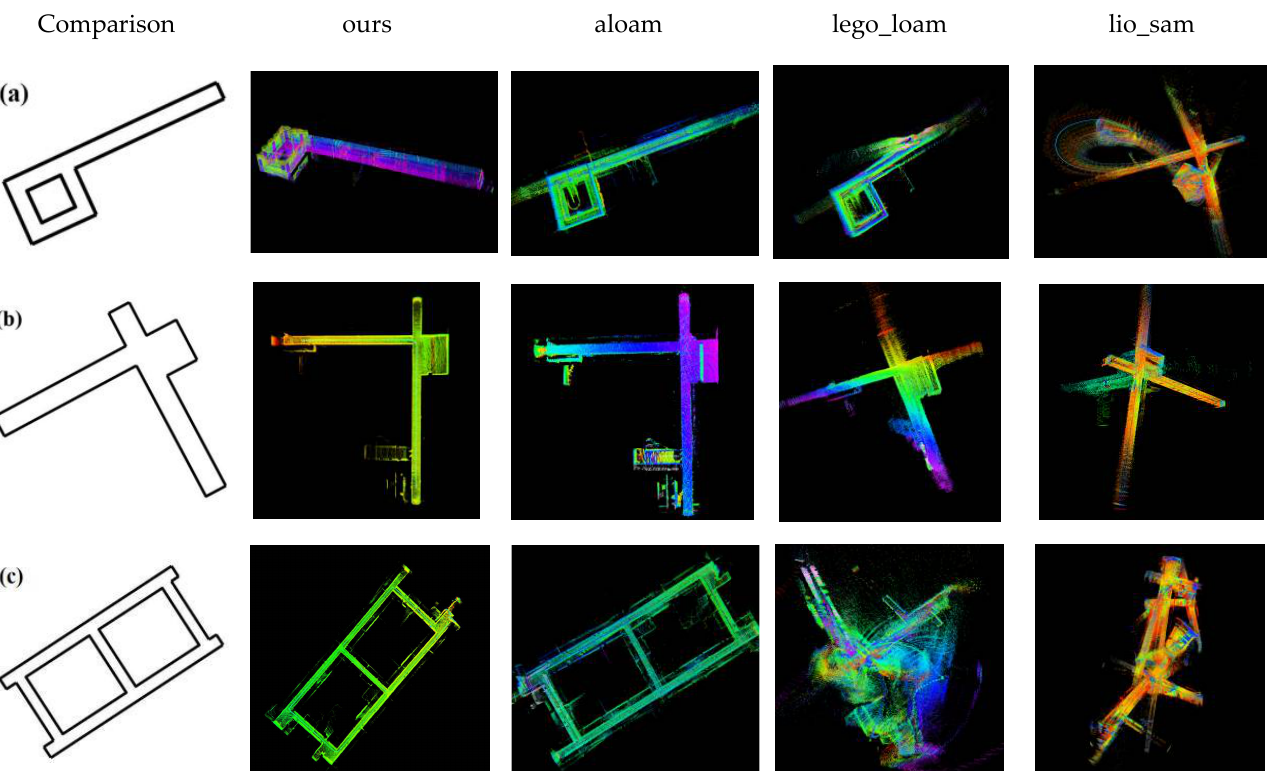
Figure 5. The point cloud map was constructed by four SLAM methods in the current experimental